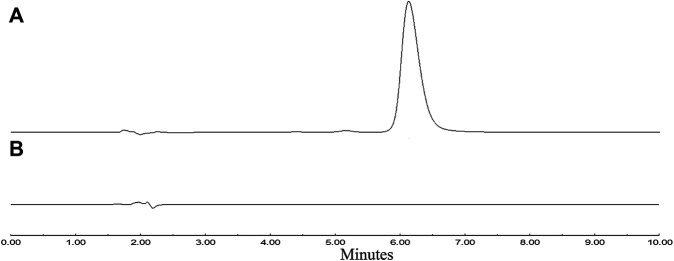
HPLC chromatogram. (A): POC, (B): blank solvent.